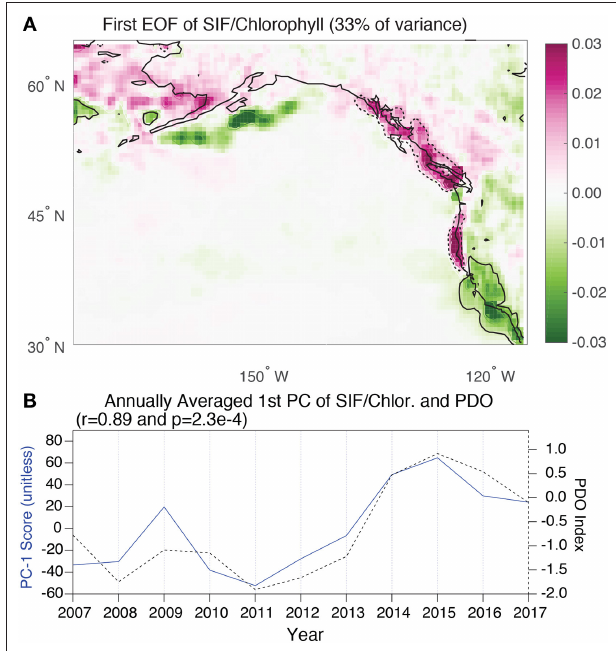
FIGURE 5 | (A) The first EOF of the merged normalized SIF and chlorophyll maps for the region of interest. The units are dimensionless loadings with an explained variance of 33%. The dark contour (dotted and continuous) are used to highlight particular areas of synchrony and asynchrony, respectively. (B) The first annually-averaged PC vector associated with the EOF shown in above panel. The PC timeseries is plotted alongside the annually-averaged PDO index ( r = 0.89).